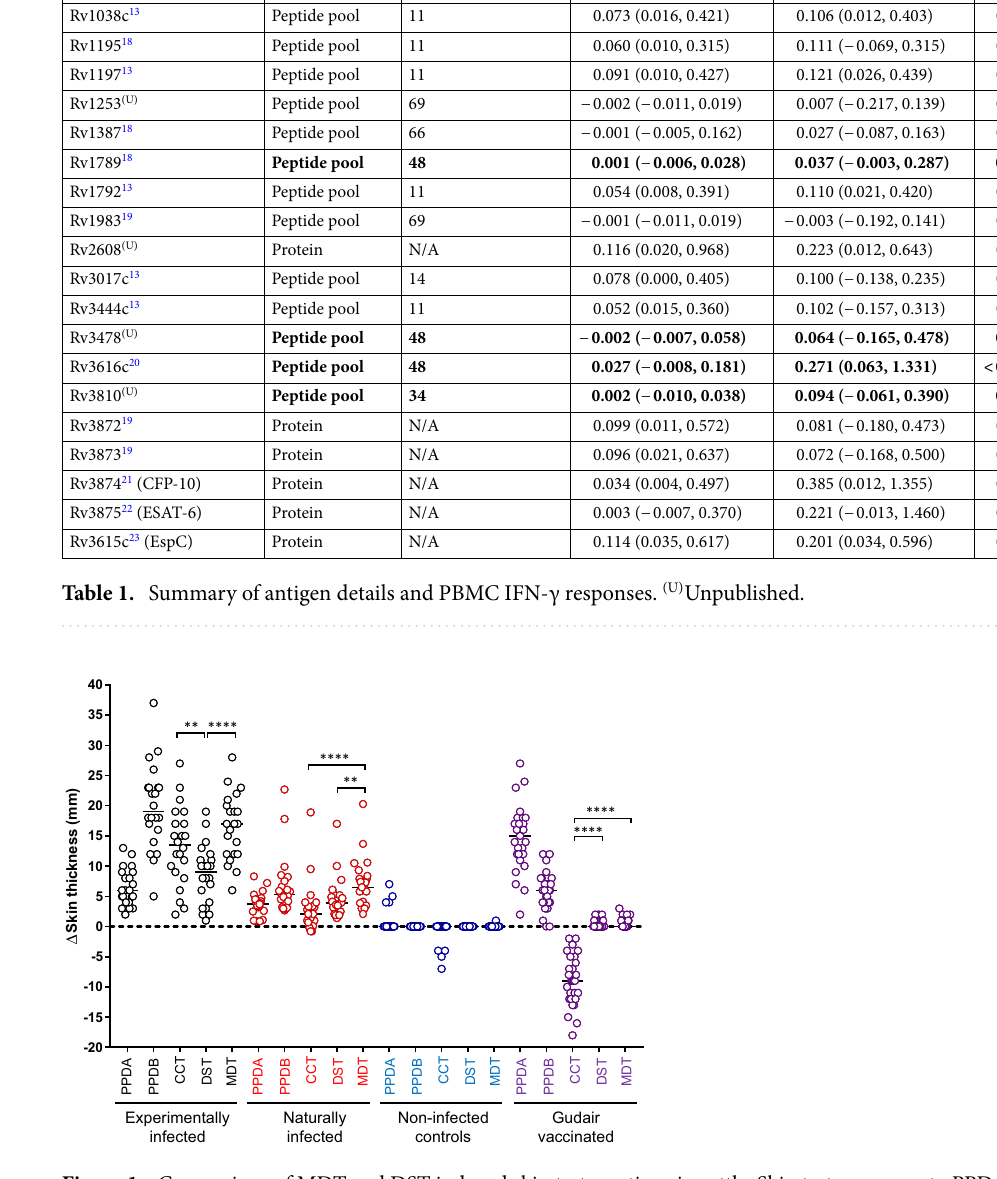
Fig. 1. As expected strong PPD-B responses were observed in both groups of M. bovis infected animals result- ing in a strongly PPD-B-biased CCT (PPD-B minus PPD-A) response (Fig. 1). Experimentally infected calves exhibited significantly stronger skin responses to MDT than to DST ( p < 0.0001), and responses to DST were also significantly lower compared to the CCT ( p = 0.0060). The significantly increased reactivity of MDT compared